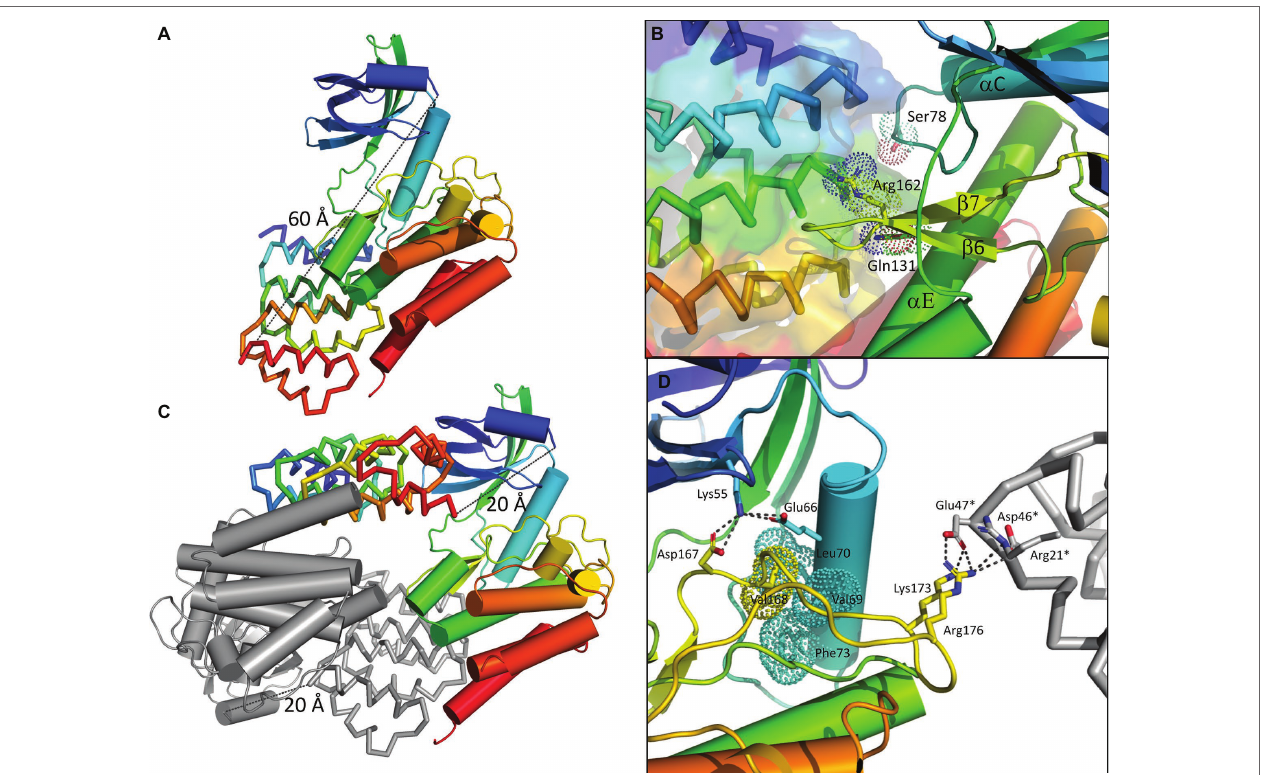
FIGURE 4 | Structure of the bE8-YabT( ∆ TM) fusion proteins. (A) Overall structure of the bE8-YabT( ∆ TM) monomeric form. The YabT( ∆ TM) is shown in cartoon format and the bE8 α REP binder as ribbon. Both domains are colored in a rainbow scheme from blue (N-terminus) to red (C-terminus). The secondary structure elements of YabT( ∆ TM) are labeled. The linker region is not visible, but both domains display the characteristic α REP interaction mode. The distance of 60 Å separating the C-terminus of bE8 from the N-terminus of YabT is highlighted by a dashed line. It is compatible with a 32 residues long linker. (B) Close view of the bE8/YabT( ∆ TM) interaction. The bE8 surface is shown in transparency. YabT residues directly implicated in polar interactions with bE8 are labeled and shown in sticks and dots. (C) Alternative dimeric form of the bE8-YabT( ∆ TM) fusion protein observed in crystal packing. A subunit is shown in the same scheme as in panel A. The second subunit is shown in gray. In each subunit, the C-terminus of the bE8 domain is only 20 Å apart from the N-terminus of the YabT( ∆ TM) domain but specifically interact with the YabT( ∆ TM) domain of the second subunit. (D) Characteristics of the active closed conformation. The electrostatic interactions made by Lys55 from strand β 3 and residues Lys173 and Arg176 from the activation loop are highlighted by dashed lines. The hydrophobic interactions between Val168 from the activation loop (yellow) and helix α C (cyan) are highlighted by dots. A neighboring bE8 molecule from the crystal packing is shown as gray ribbon with residues Arg21*, Asp46*, and Glu47* in